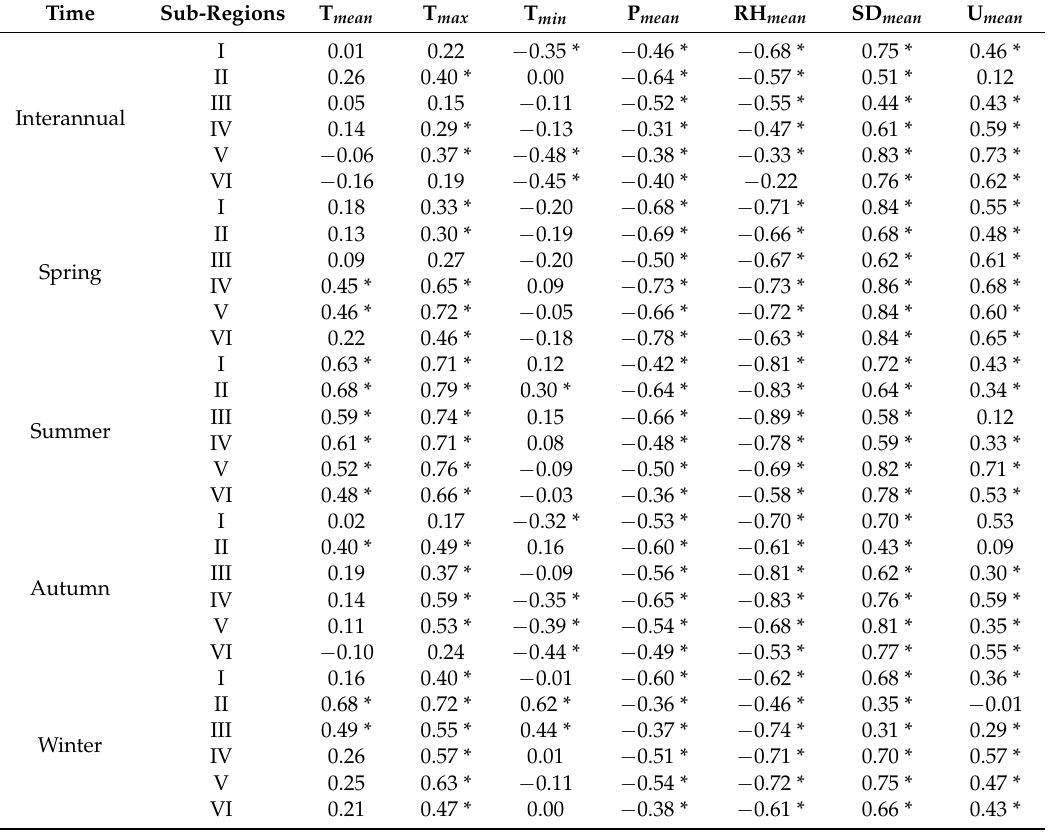
Table 5. The Spearman correlation coefficients between Meteorological Elements and E pan per